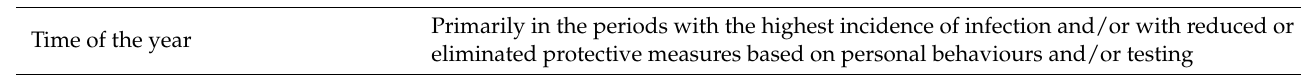
Table 1. Sampling strategy for airborne SARS-CoV-2.